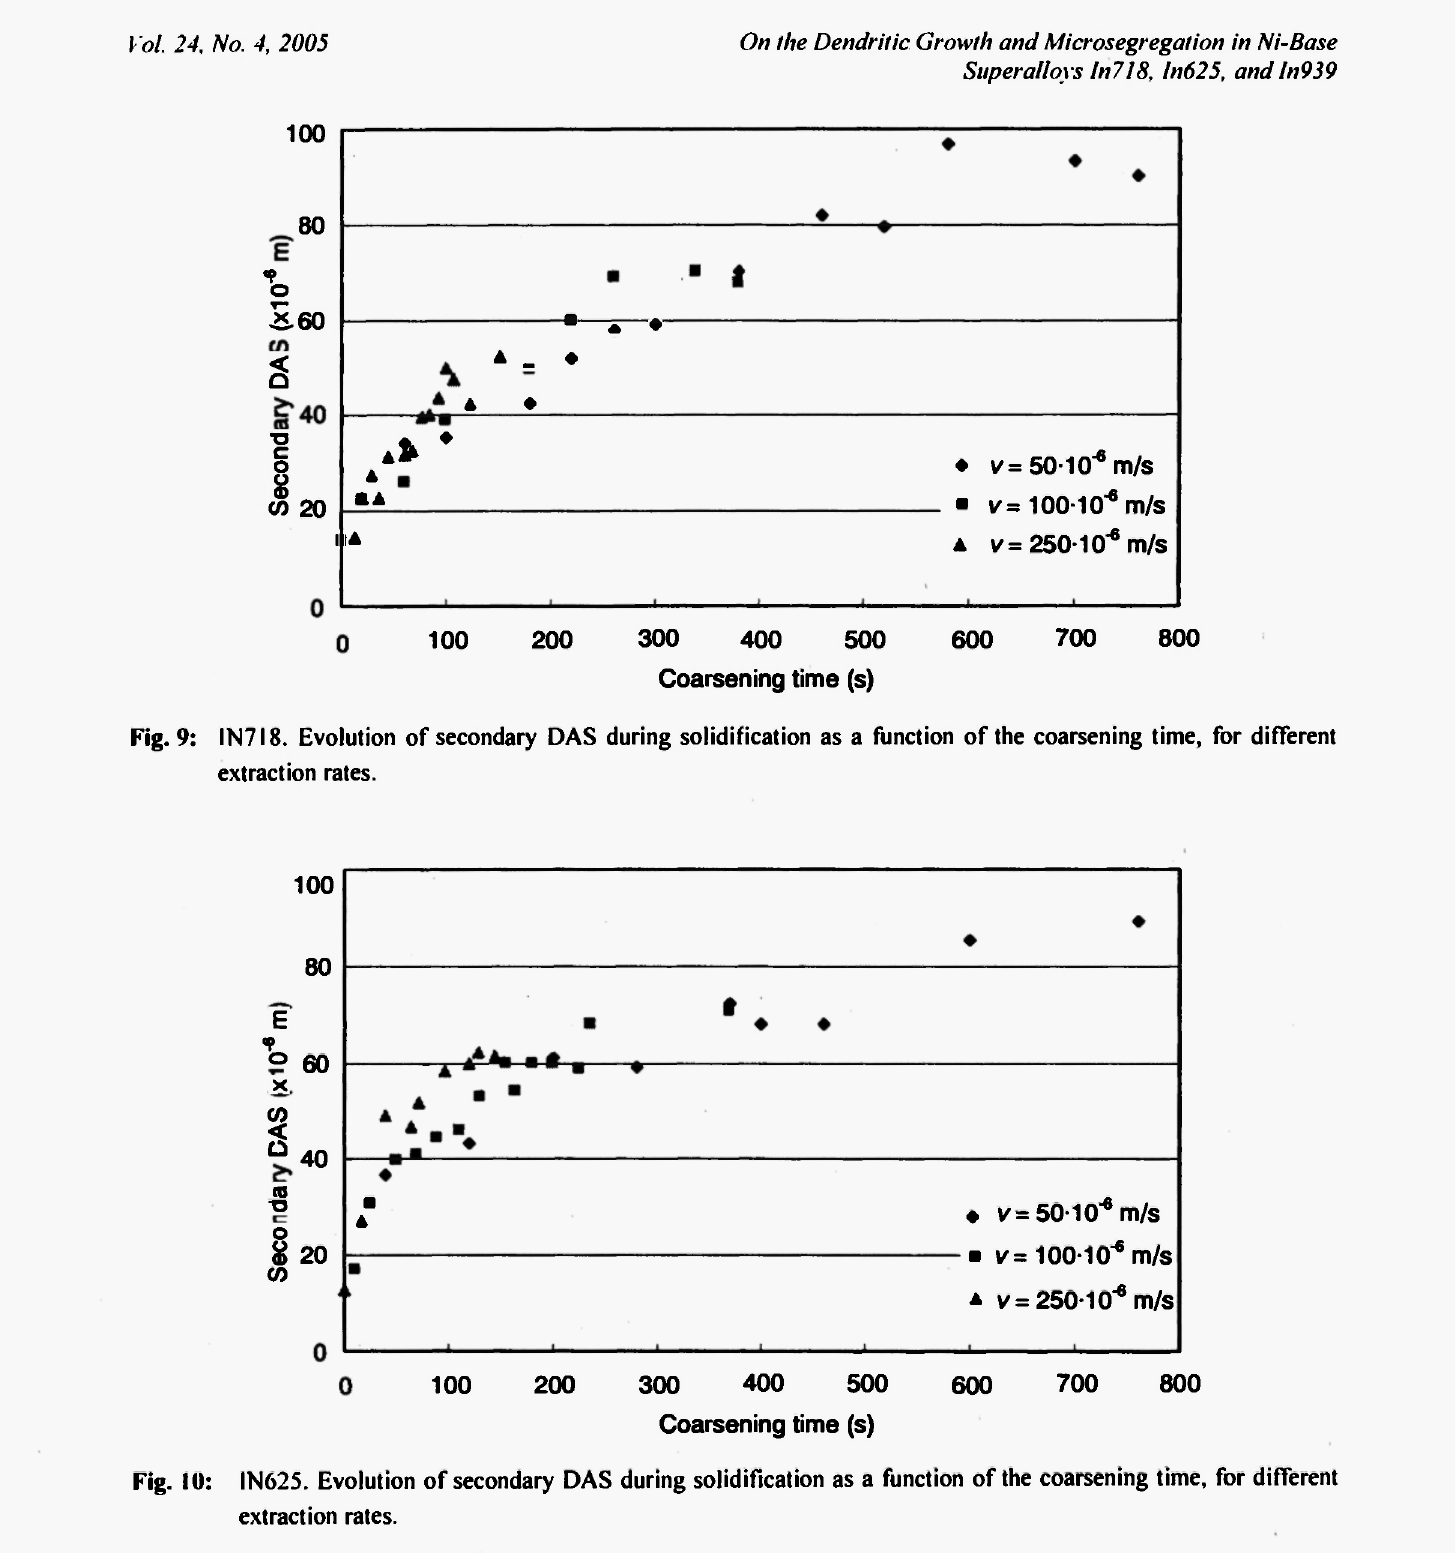
Fig. 10: IN625. Evolution of secondary DAS during solidification as a function of the coarsening time, for different extraction